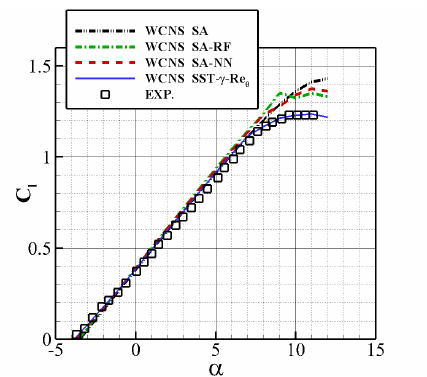
Figure 14. Lift coefficient of E387